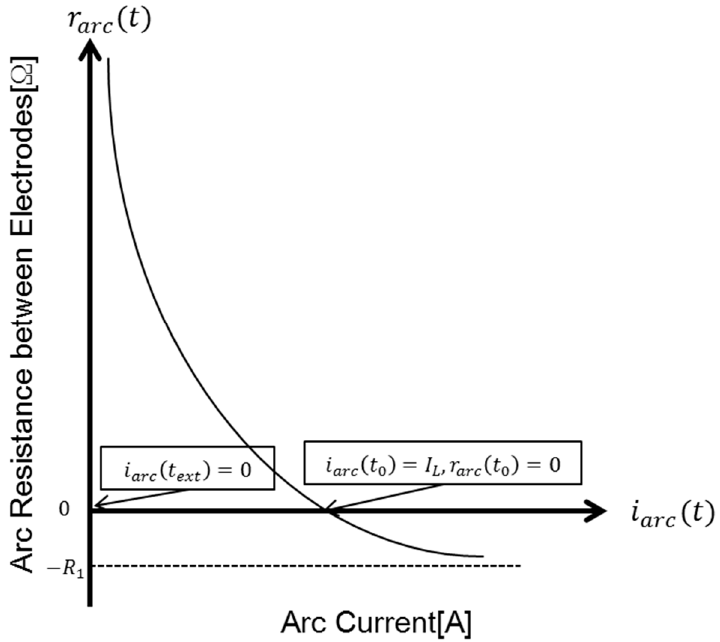
Figure 11. Relation between arc resistance, source voltage, arc current, and load resistance relation graph.